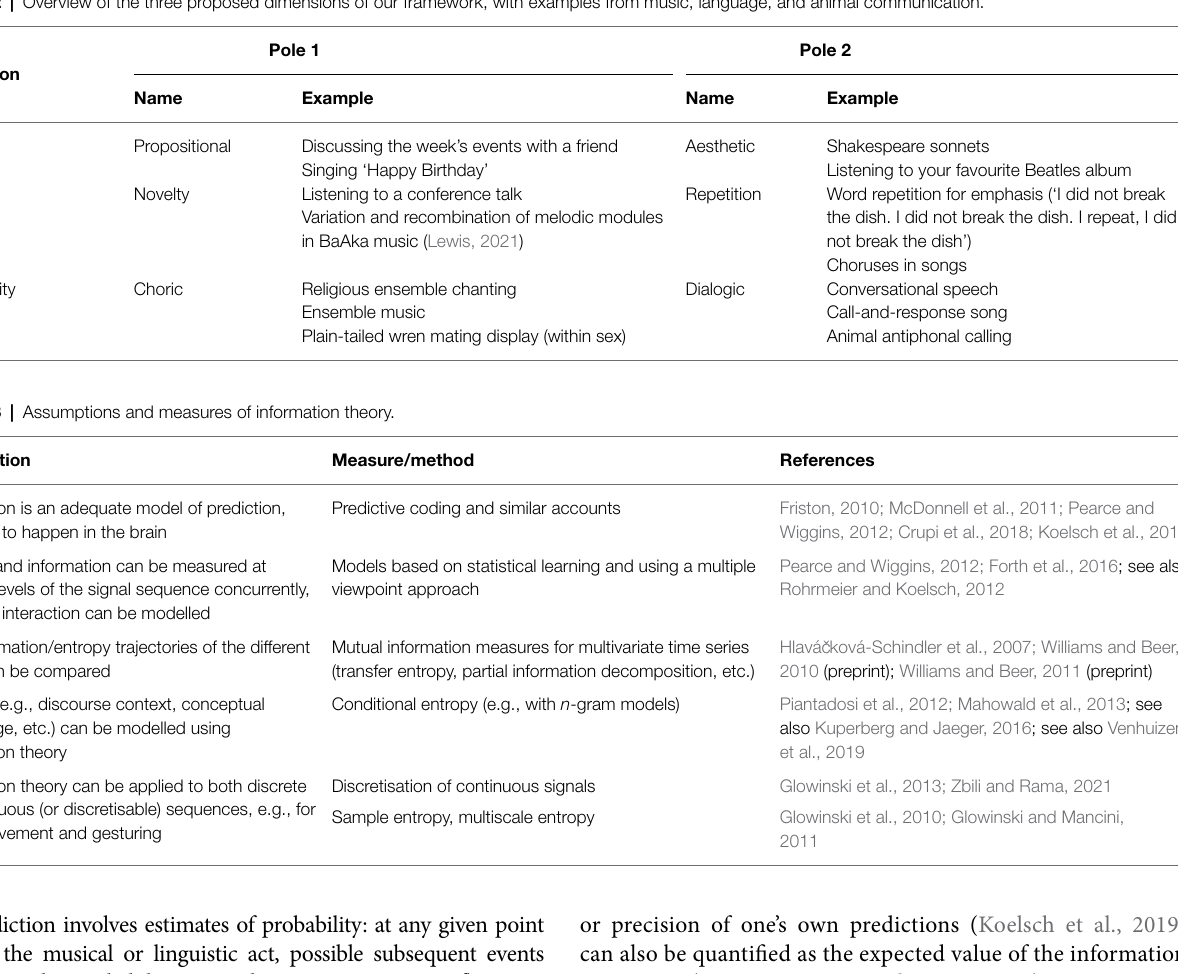
TABLE 2 | Overview of the three proposed dimensions of our framework, with examples from music, language, and animal communication.